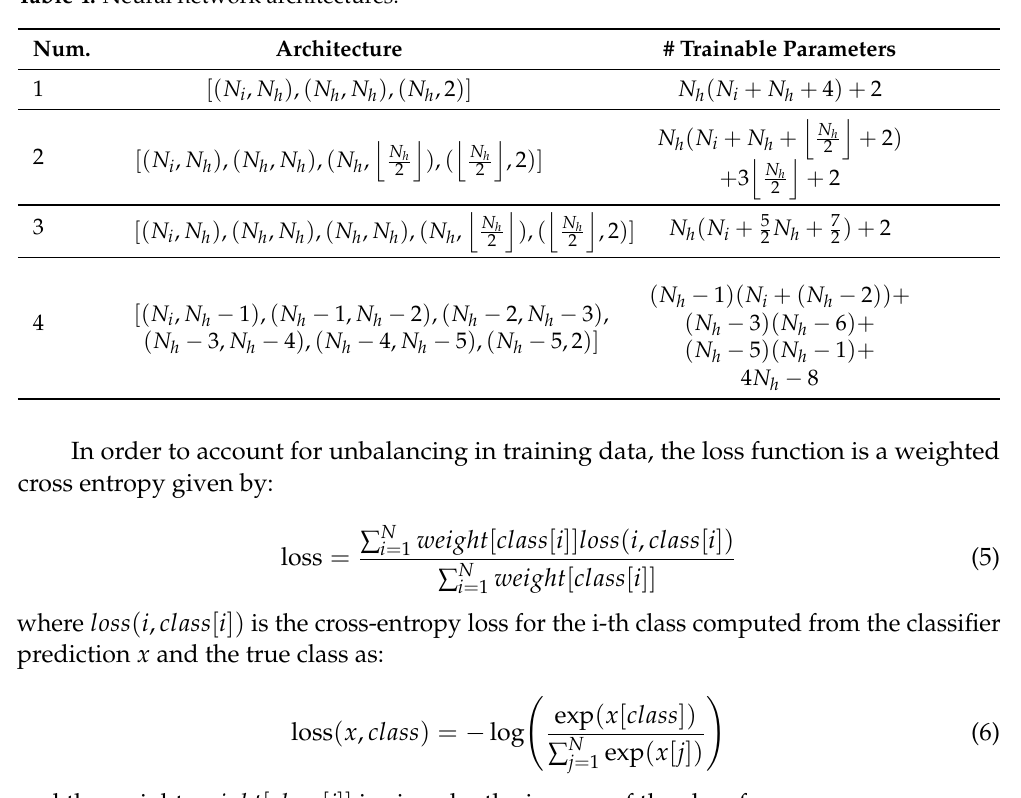
Table 4. Neural network